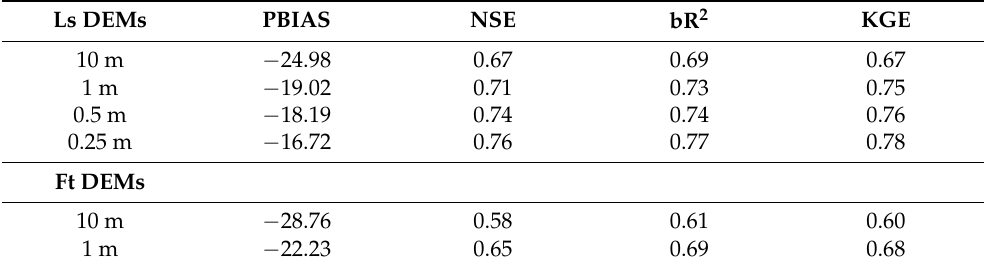
Table 3. Goodness-of-fit indicators for model performance when using LIDAR (Ls) and photogram- metric (Ft) DEMs as input for SWAT. Ls DEMs PBIAS